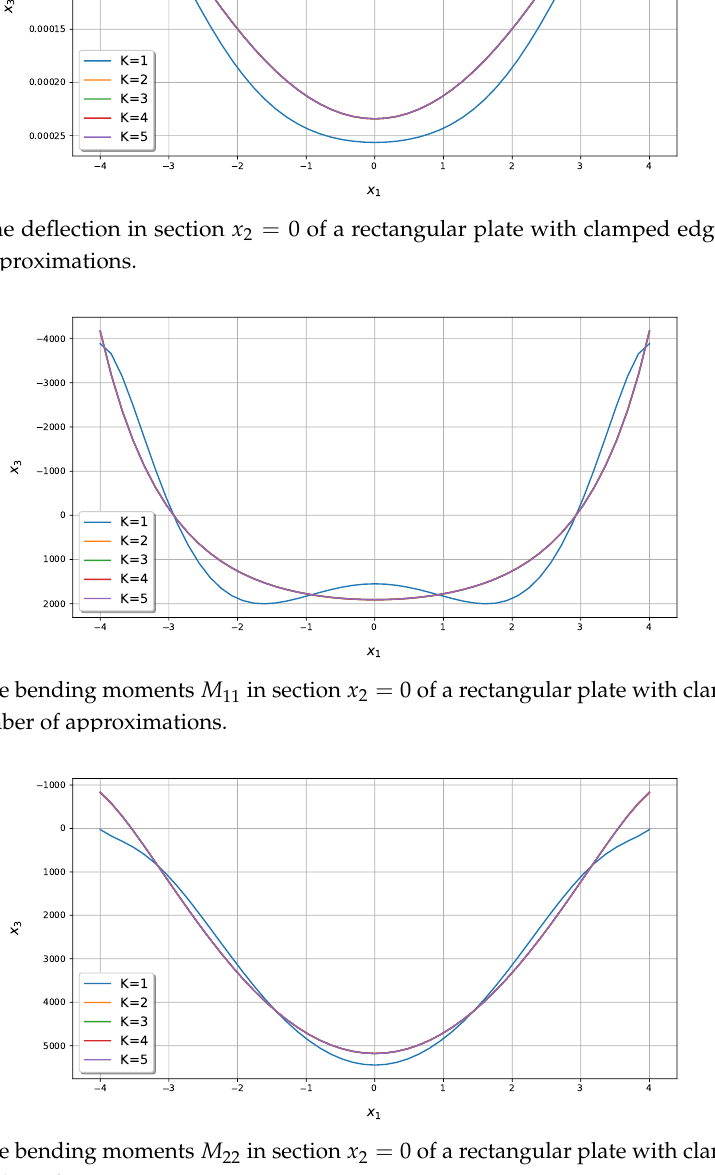
Figure 28. The bending moments M 22 in section x 2 = 0 of a rectangular plate with clamped edges for different number of